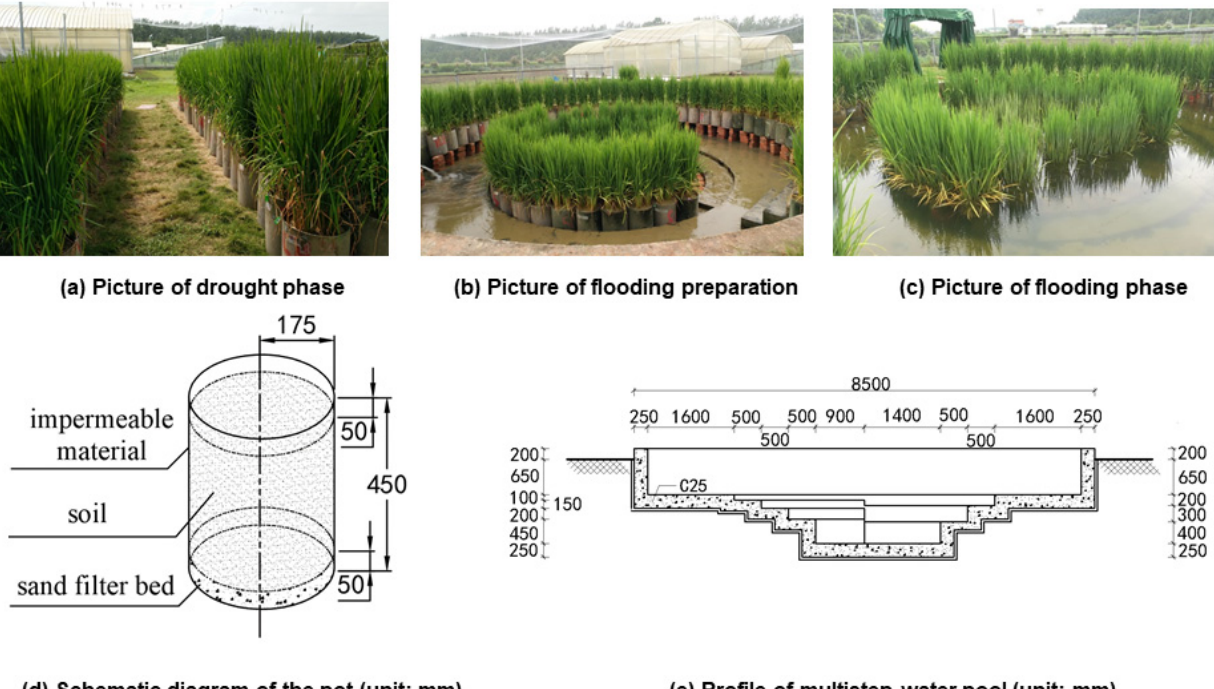
Figure 2. Photos of drought phase, flooding preparation and flooding phase ( a – c ), schematic diagrams of the pots for rice growth ( d ) and the profile of multistep water pool for different flooding depths ( e ).